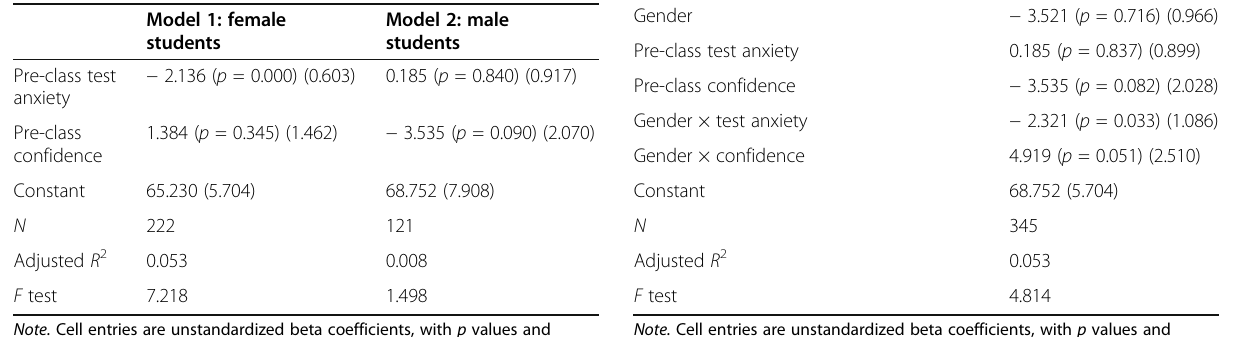
Table 2 Ordinary least squares regressions for predicting student class performance based on test anxiety and confidence OLS regressions: confidence, test anxiety, and class performance